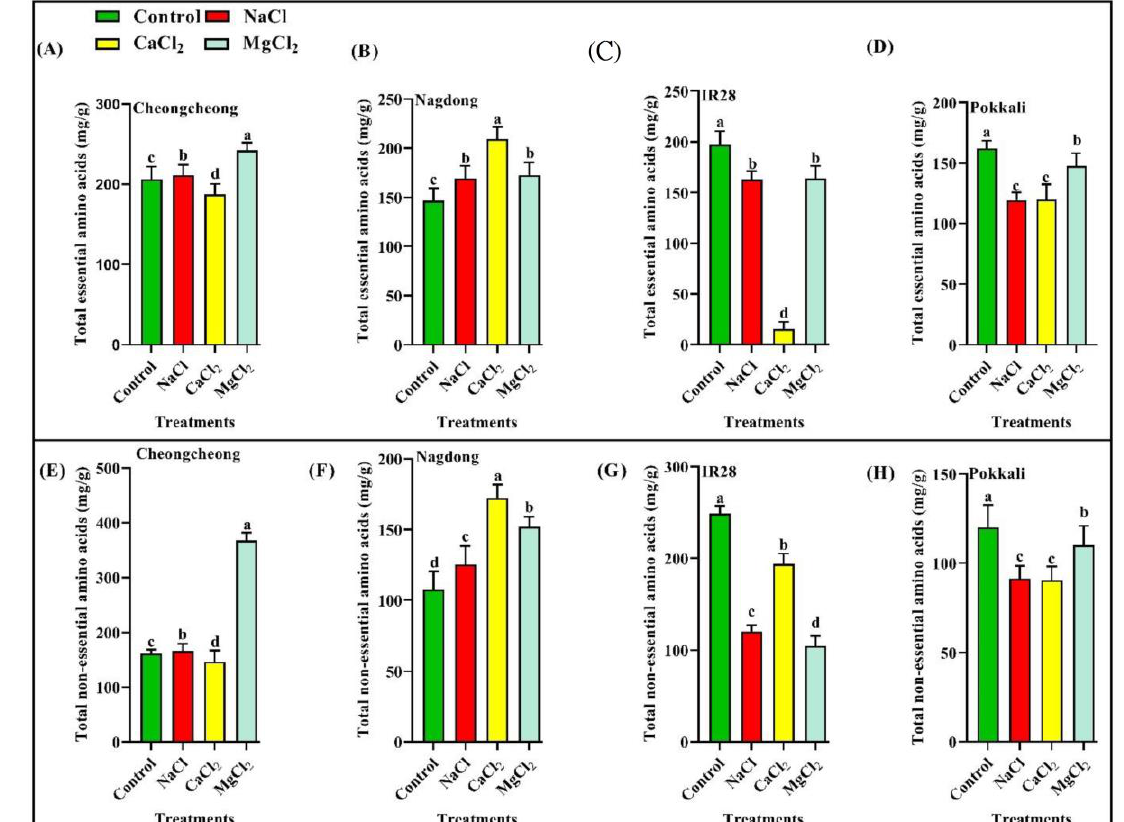
Figure 1. Effect of salinity stress conditions on total amino acid profiles in rice genotypes. Total essential and non-essential amino acid contents were determined after 24 h of 150 mM salinity stress. ( A , B , E , F ) are cultivars Cheongcheong and Nagdong, whereas ( C , D , G , H ) show cultivars IR28 and Pokkali. Different characters on the bars indicate significant differences. However, Duncan’s multiple range test, p 0.05, shows that the means of the similar letters are not statistically